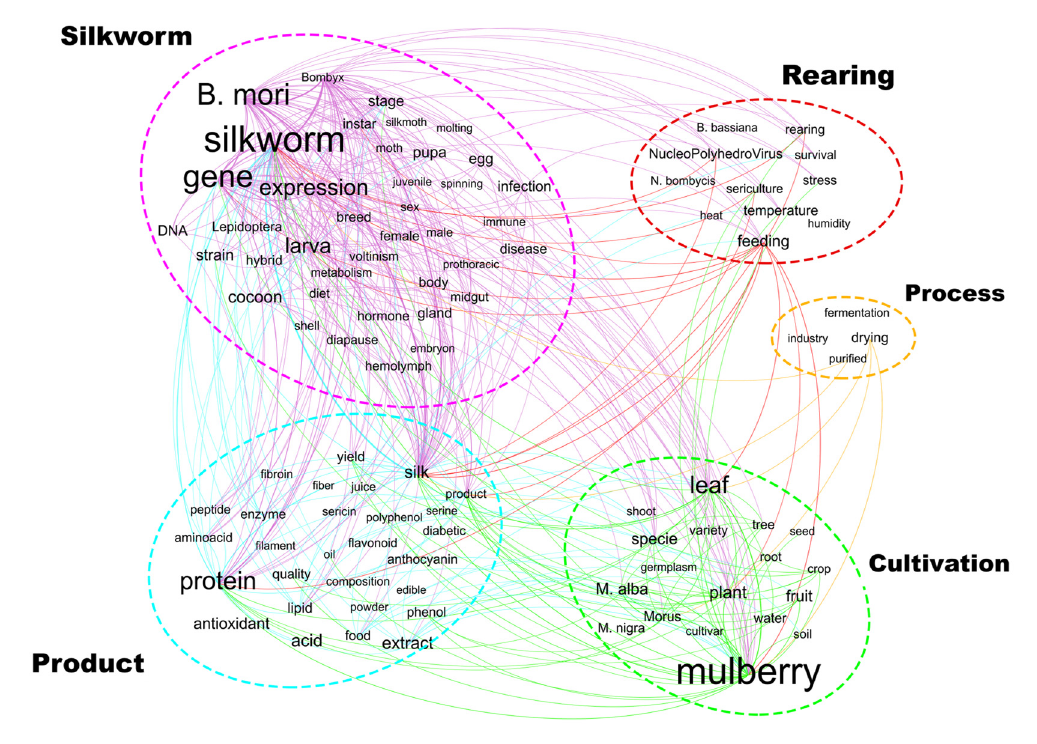
Figure 5. Interrelations among the top 100 most frequent words. In this picture, the curved lines represent relevant interrelations (number of co-occurrences is greater than